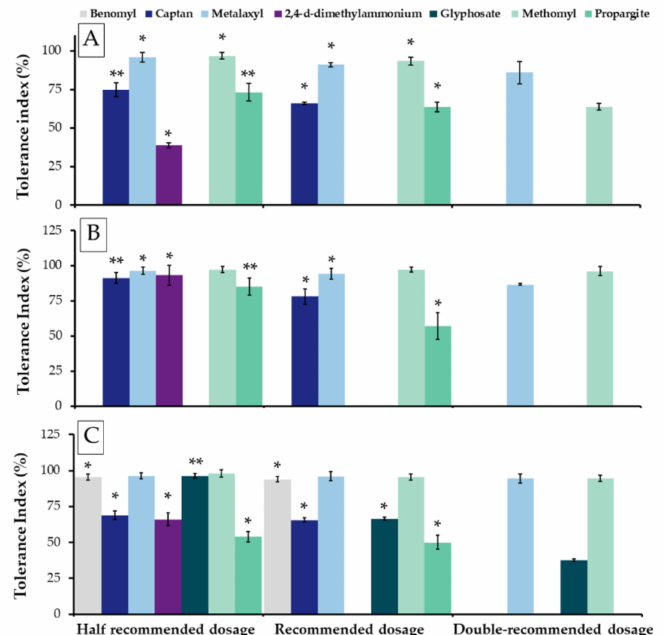
Figure 3. Comparison of the tolerance index of ten agrochemicals at different dosages of three actinobacteria; Streptomyces sp. GETU-1 ( A ); Streptomyces sp. GIG-1 ( B ); and Amycolatopsis sp. GLM-2 ( C ). Each bar indicates the standard deviation of the mean values. “*” and “**” indicates significant difference by DMRT at p < 0.05 in different dosages of the same agrochemical.